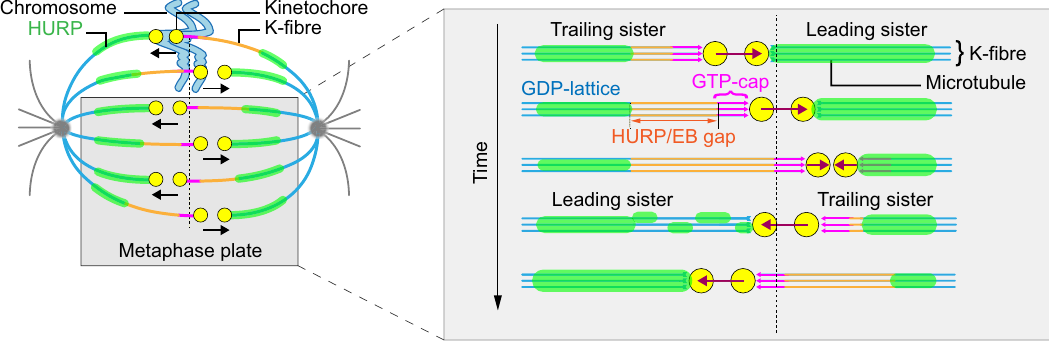
Fig. 7 | Proposed modelofthe mixed-nucleotidezone onK- fi bres. Basedonour experimentaldata,weproposethatK- fi brescontainfourdistinctregions:(1)AGTP- cap (magenta) close to the trailing kinetochore, characterised by an accumulation of EB proteins; (2) a micron-sized dynamic mixed-nucleotide zone (orange) on growing K- fi bres that contains neither EB proteins nor HURP; (3) the GDP